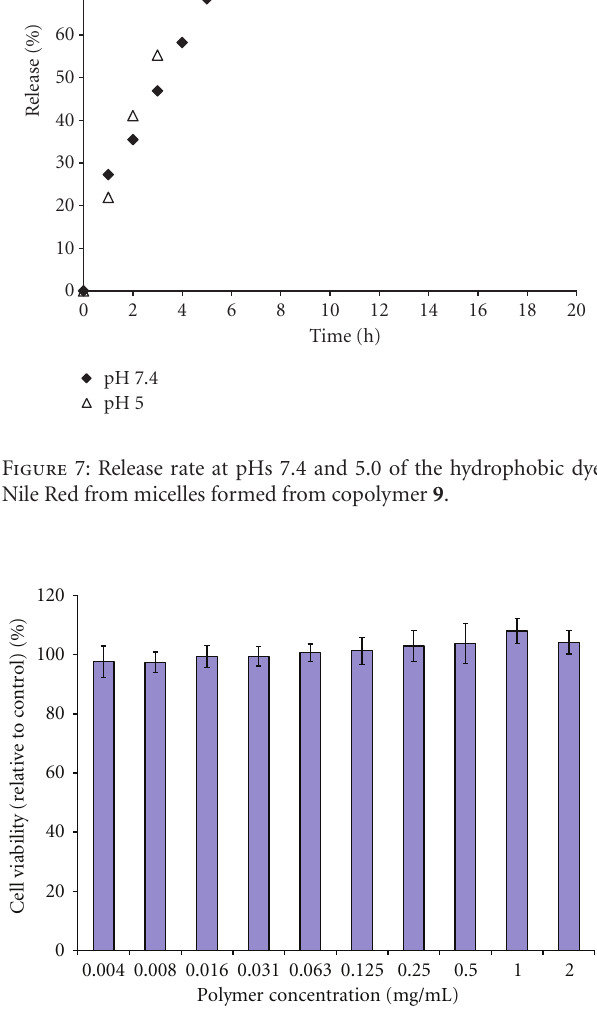
Figure 8: Assessment of the in vitro toxicity of micelles formed from copolymer 9 . An MTT assay was performed following 48 hours of incubation of varying concentrations of micelles with HeLa